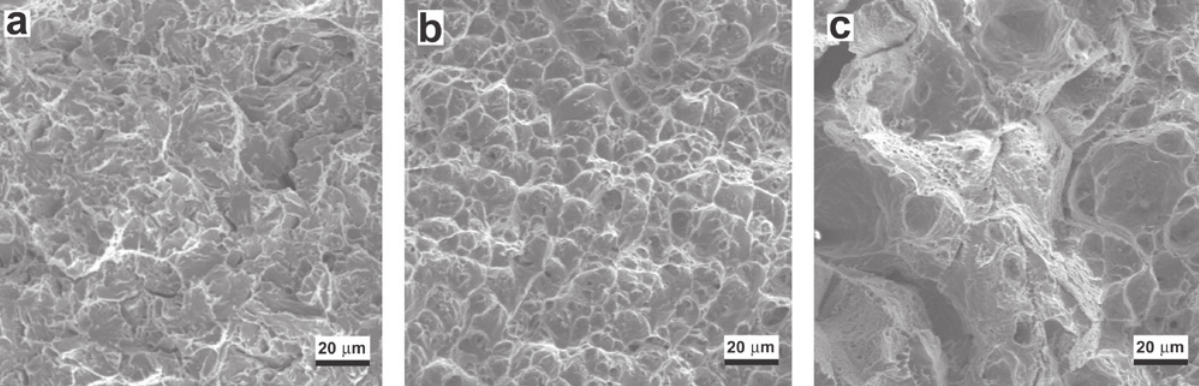
Fig. 9: SEM-fractographs of different regions of the studied weldment in thermally exposed state at 600 °C/5000 h after room-temperature tensile testing without hydrogen charging: T91 steel HAZ (a), Ni WM Thermanit Nicro 82 (b), TP316H steel HAZ (c).